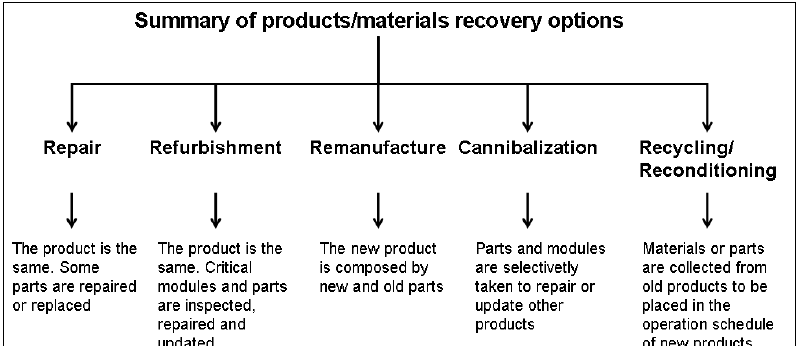
Figure 1: The Recovery Options in the Reversed